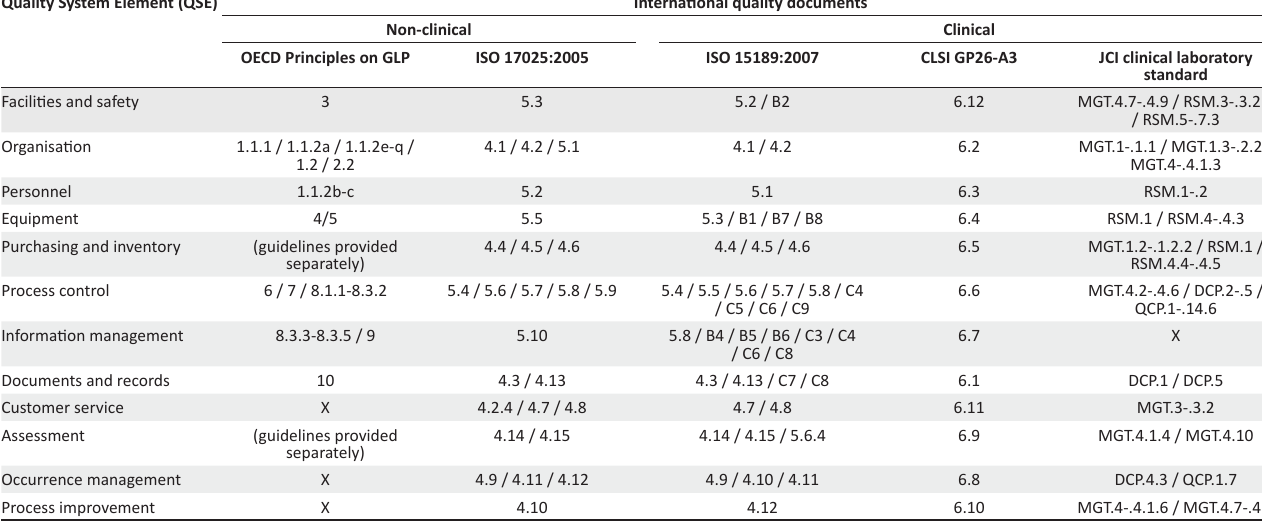
TABLE 2b: Analysis of contents of international quality documents using the Quality System Essentials framework. Quality System Element